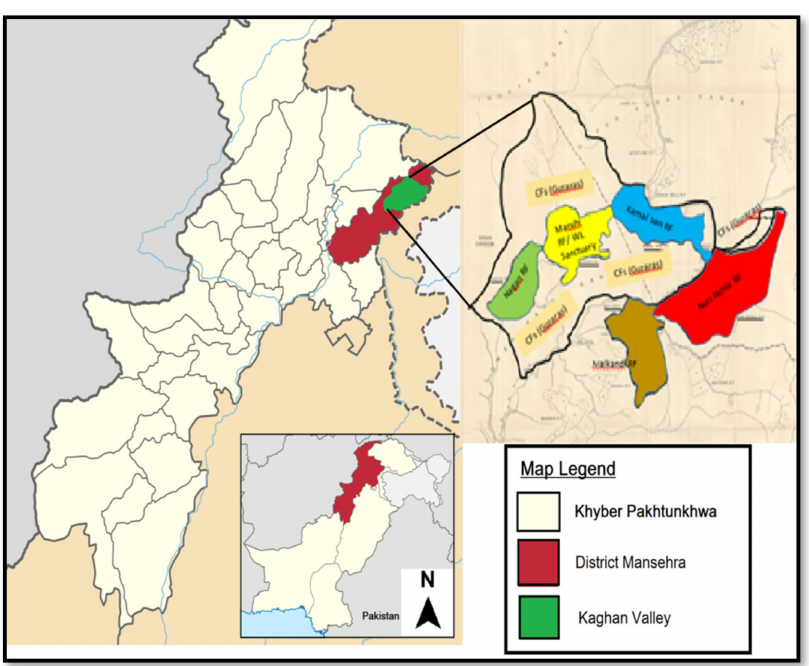
Figure 1. Map of Kaghan Valley,